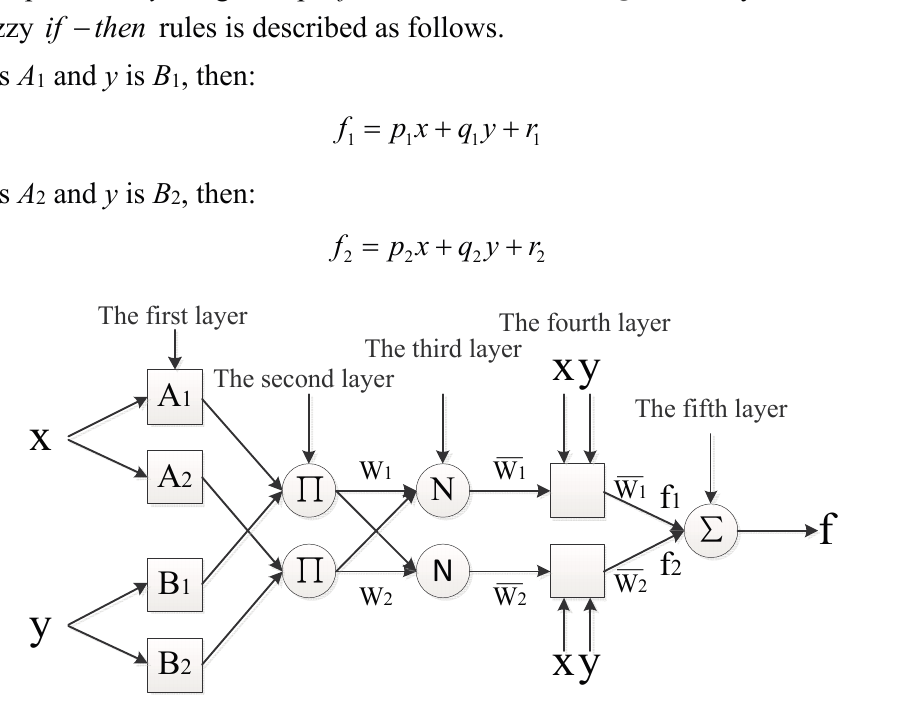
Figure 1. Typical ANFIS structure